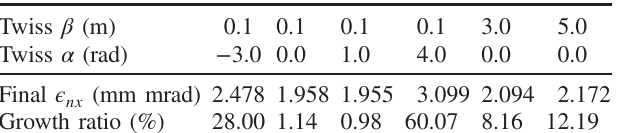
TABLE III. Final normalized emittance from the achromatic dog-leg transfer line. Before entering the dog-leg transfer line, the initial beam emittance was 1.936 mm mrad. Growth ratio was calculated with respect to the initial